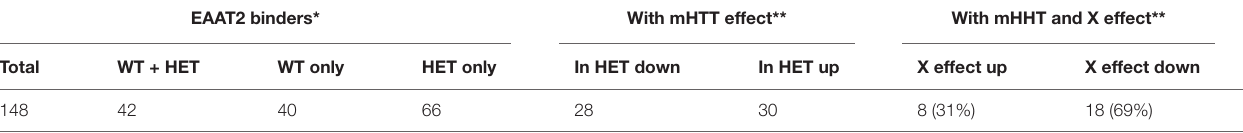
TABLE 1 | Summary binders with mHTT-related difference and effect of EAAT2 C-terminal truncation. EAAT2 binders* With mHTT effect**